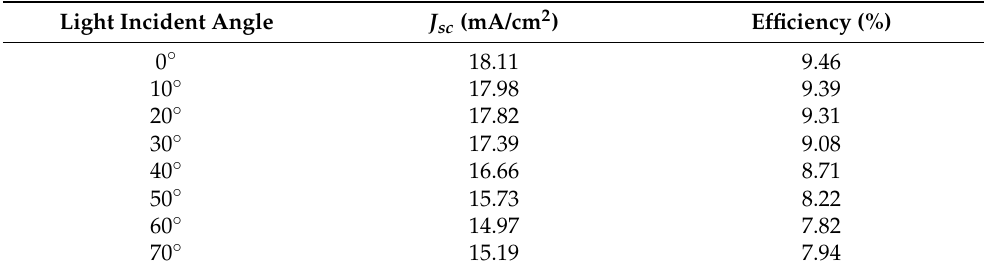
Table 4. J sc and PCE for different light incident angles.